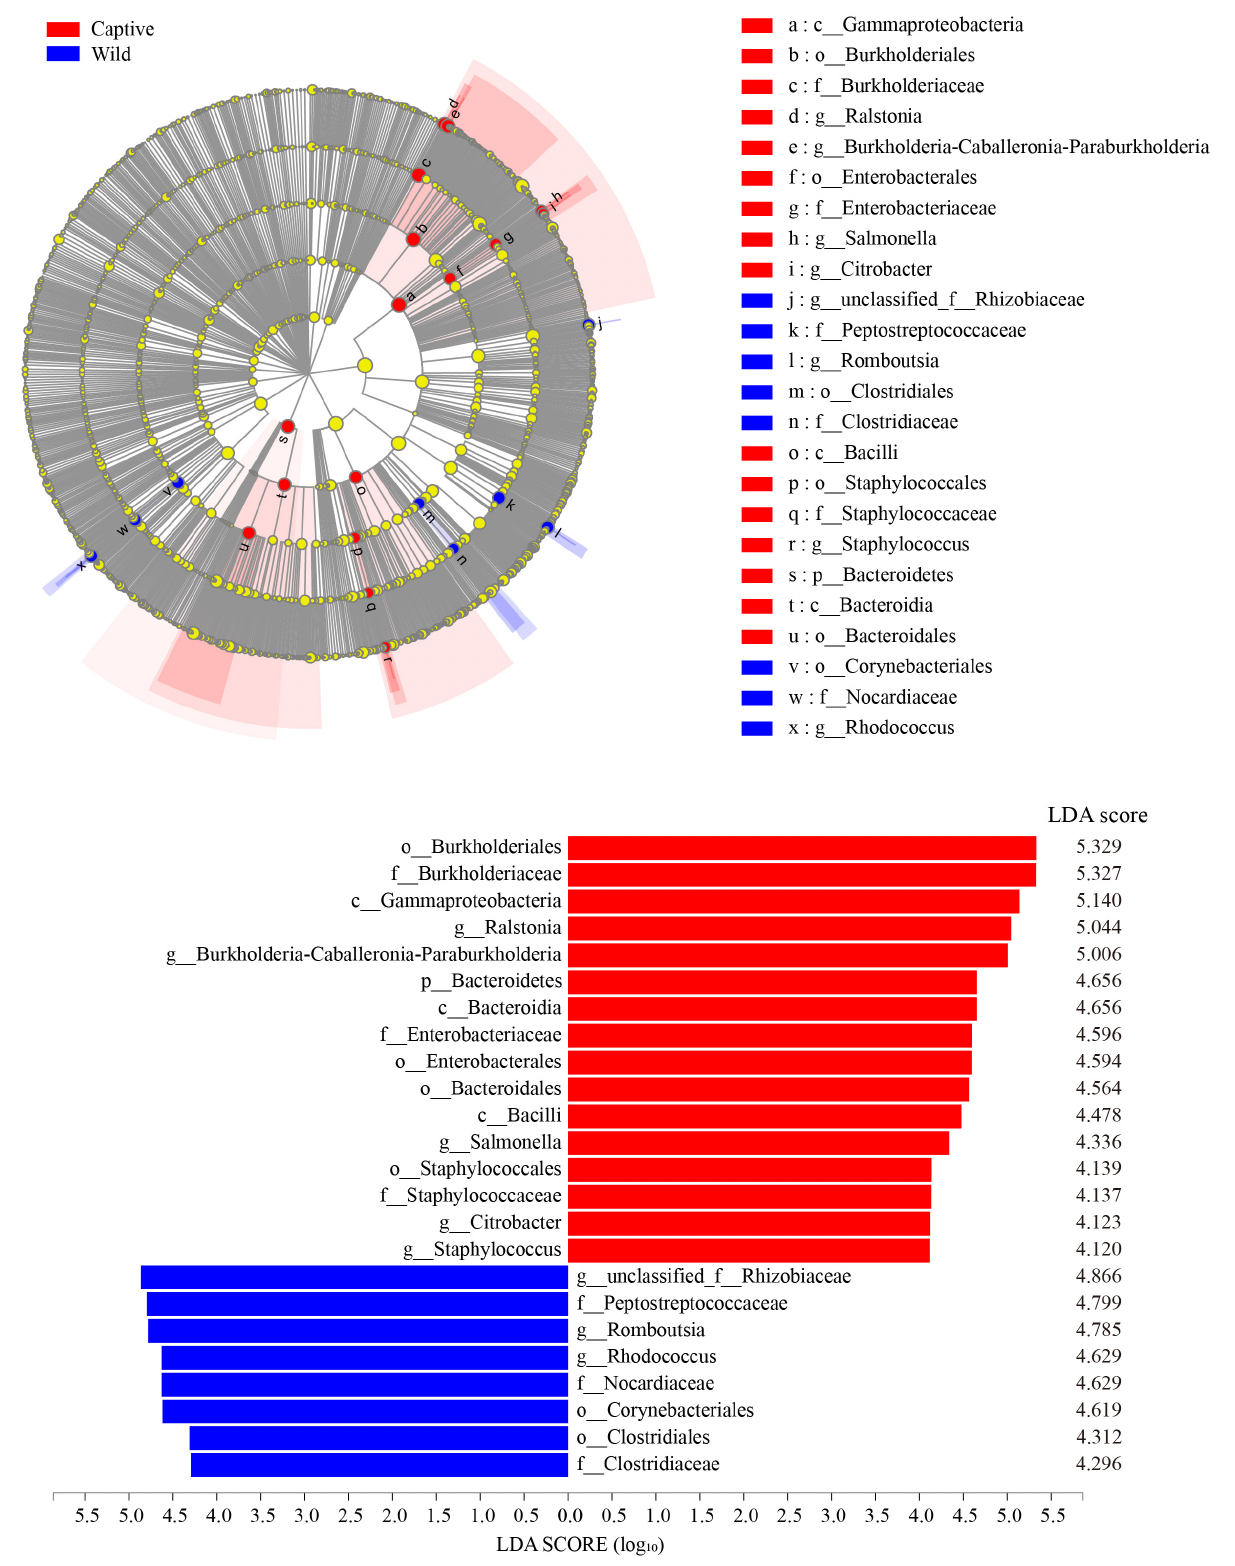
FIGURE 6 | LEfSe (LDA Effect Size) analysis of the gut microbiota in Tokay gecko (LDA score > 4.0).